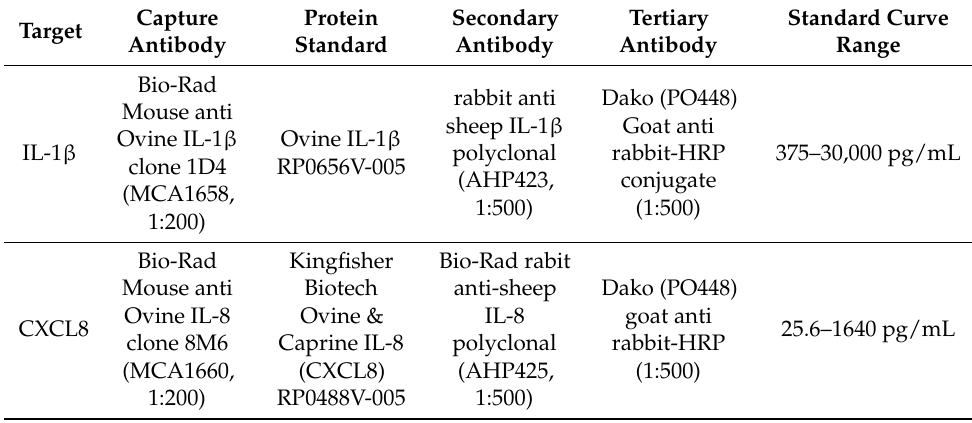
Table 2. ELISA antibodies and dilutions for each protein